Question: Describe this figure in one sentence.
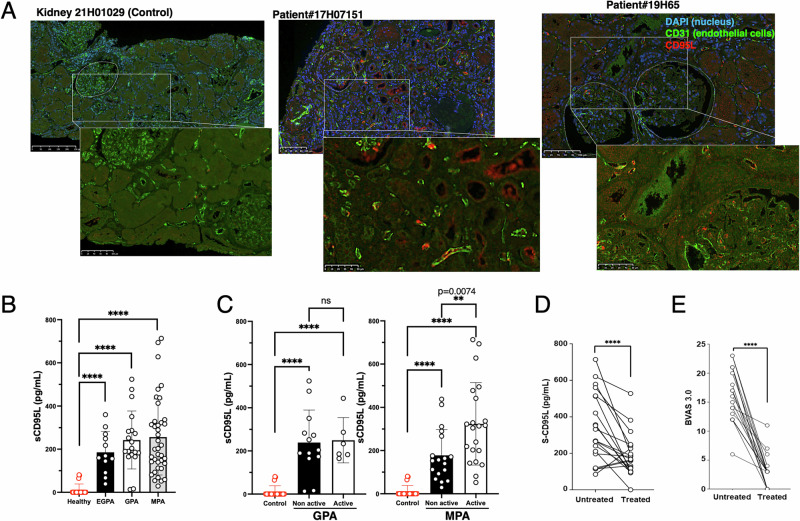
Answer: CD95L expression is increased in AAV Patients. A CD95L (in red) and CD31 (marker of endothelial cells) (in green) staining were performed on kidney biopsies from one healthy control (21H01029, left panel ) or two AAV patients (17H07151 and 19H65, right panel ) by immunofluorescence. Dashed thin white lines indicate glomeruli. Nuclei are stained using DAPI in blue. Scale bars represent 250 and 100 µm in the magnified images for the control kidney, 100 and 50 µm in the magnified images for Patient#17H07151 and 100 and 50 µm in the magnified images for Patient#19H65 kidney. B , C Dosage of serum sCD95L was performed by ELISA in indicated patients (EGPA: Eosinophilic Granulomatosis with Polyangiitis; GPA: Granulomatosis with Polyangiitis; MPA: Microscopic Polyangiitis). Healthy donors, n = 20; EGPA, n = 12; GPA, n = 19; MPA patients, n = 39. Active GPA, n = 6; non active GPA, n = 13. Active MPA, n = 21; non active MPA, n = 18. Data represent mean ± SD; ** p <0.01, **** p < 0.0001, using two-tailed Mann-Whitney test. D Comparison of serum CD95L concentrations between AAV patients before (M0) and after treatment (M6). N = 20. *** p < 0.001, **** p < 0.0001 using two-sided Wilcoxon test. E . Comparison of BVAS 3.0 between AAV patients before and after treatment of AAV patients. N = 20. **** p < 0.0001 using two-sided Wilcoxon test.